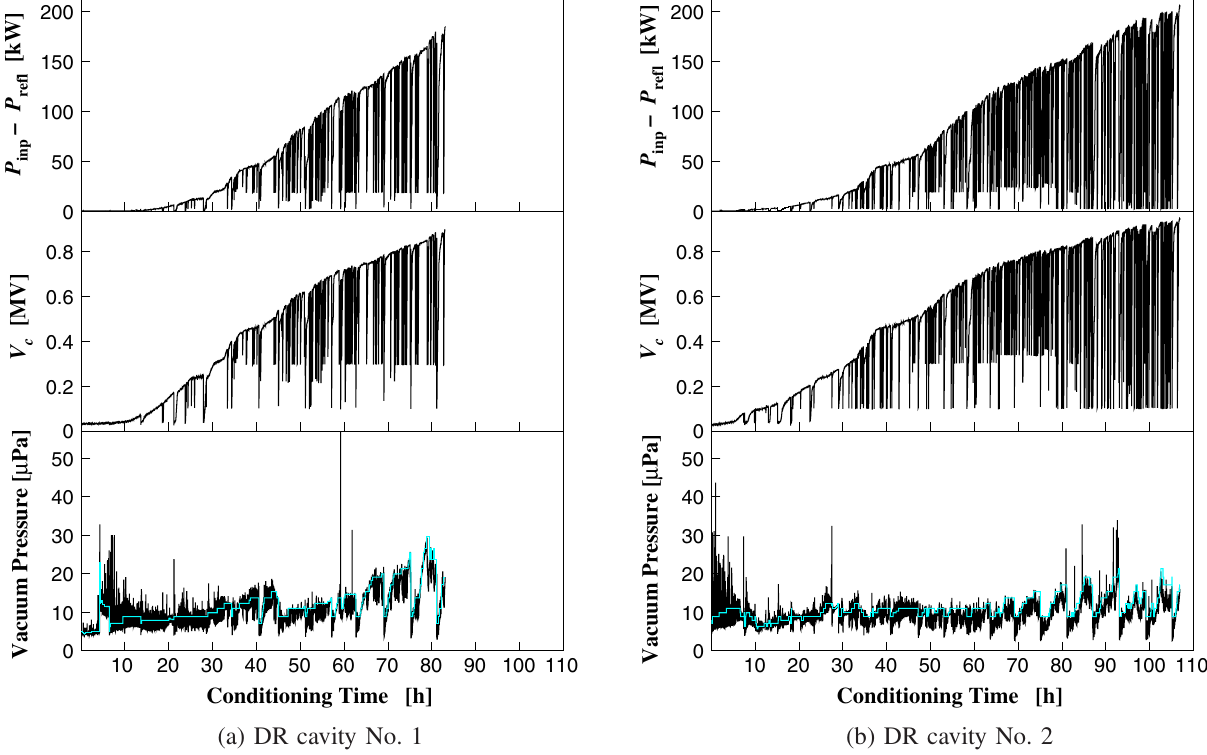
FIG. 7. Conditioning histories until V c reached (a) 0.90 MV for DR cavity No. 1 and (b) 0.95 MV for DR cavity No. 2 with data points recorded every 10 s. Data with no input rf power, data while the input rf power was kept constant, and data used to tune the control system or klystron are excluded here. The light blue lines indicate the reference vacuum pressure specified in the automatic conditioning by computer control. If the vacuum pressure is higher than the reference pressure, the rf power is stepped down until the vacuum pressure becomes lower than the reference pressure, and then the power is gradually stepped up as long as the vacuum pressure is lower than the reference pressure. The step-up slope is proportional to the difference between the reference and vacuum